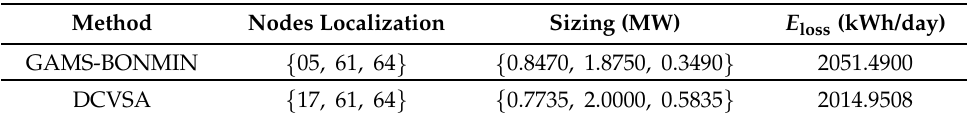
Table 9. Comparison of energy losses for the the 69-node